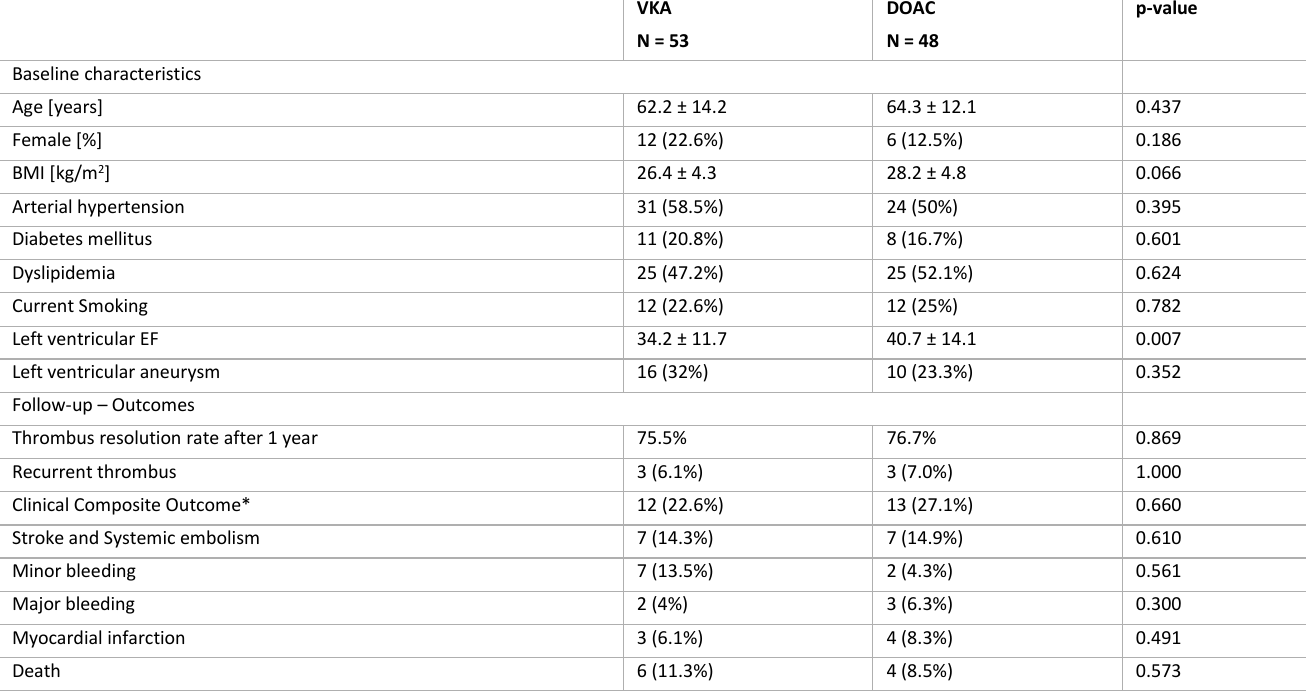
Table 1: Baseline characteristics and clinical outcomes of study population. Vitamin K Antagonists (VKA), Direct oral anticoagulants (DOAC), Body mass index (BMI), ejection fraction (EF), ST-segment elevation myocardial infarction (STEMI), Non-ST-Segment elevation myocardial infarction (NSTEMI), coronary artery disease (CAD). *Defined as a composite endpoint of stroke, systemic thromboembolism, MI, all bleedings and